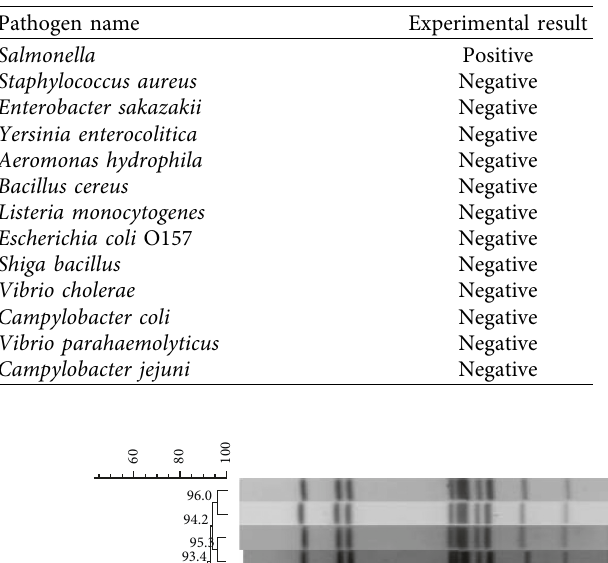
Table 4: Pathogen test results of the patients’ stool